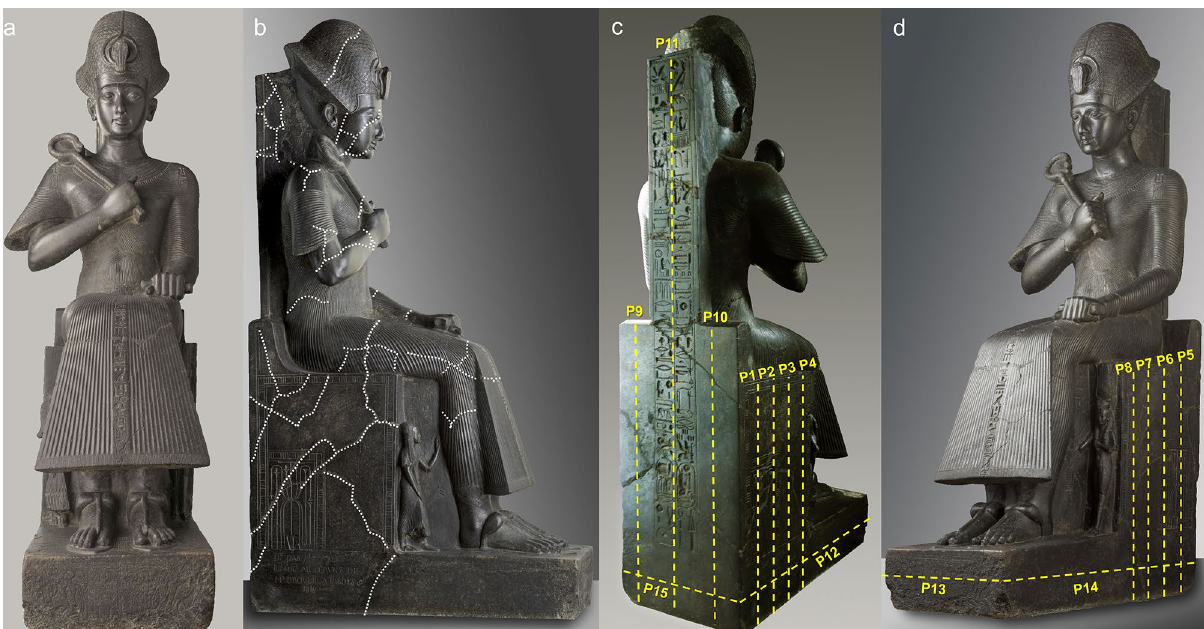
Figure 1. The statue of the young Ramses II (Museo Egizio of Torino): ( a ) frontal view; ( b ) view from the right side, with superficial fractures highlighted by white dotted lines; ( c ) back of the statue; ( d ) left side. GPR scan positions (P1 to P15) are marked by yellow dashed lines in ( c ) and ( d ). Pictures modified from the Museo Egizio online collection (https:// colle zioni. museo egizio. it/ en- GB/ mater ial/ Cat_